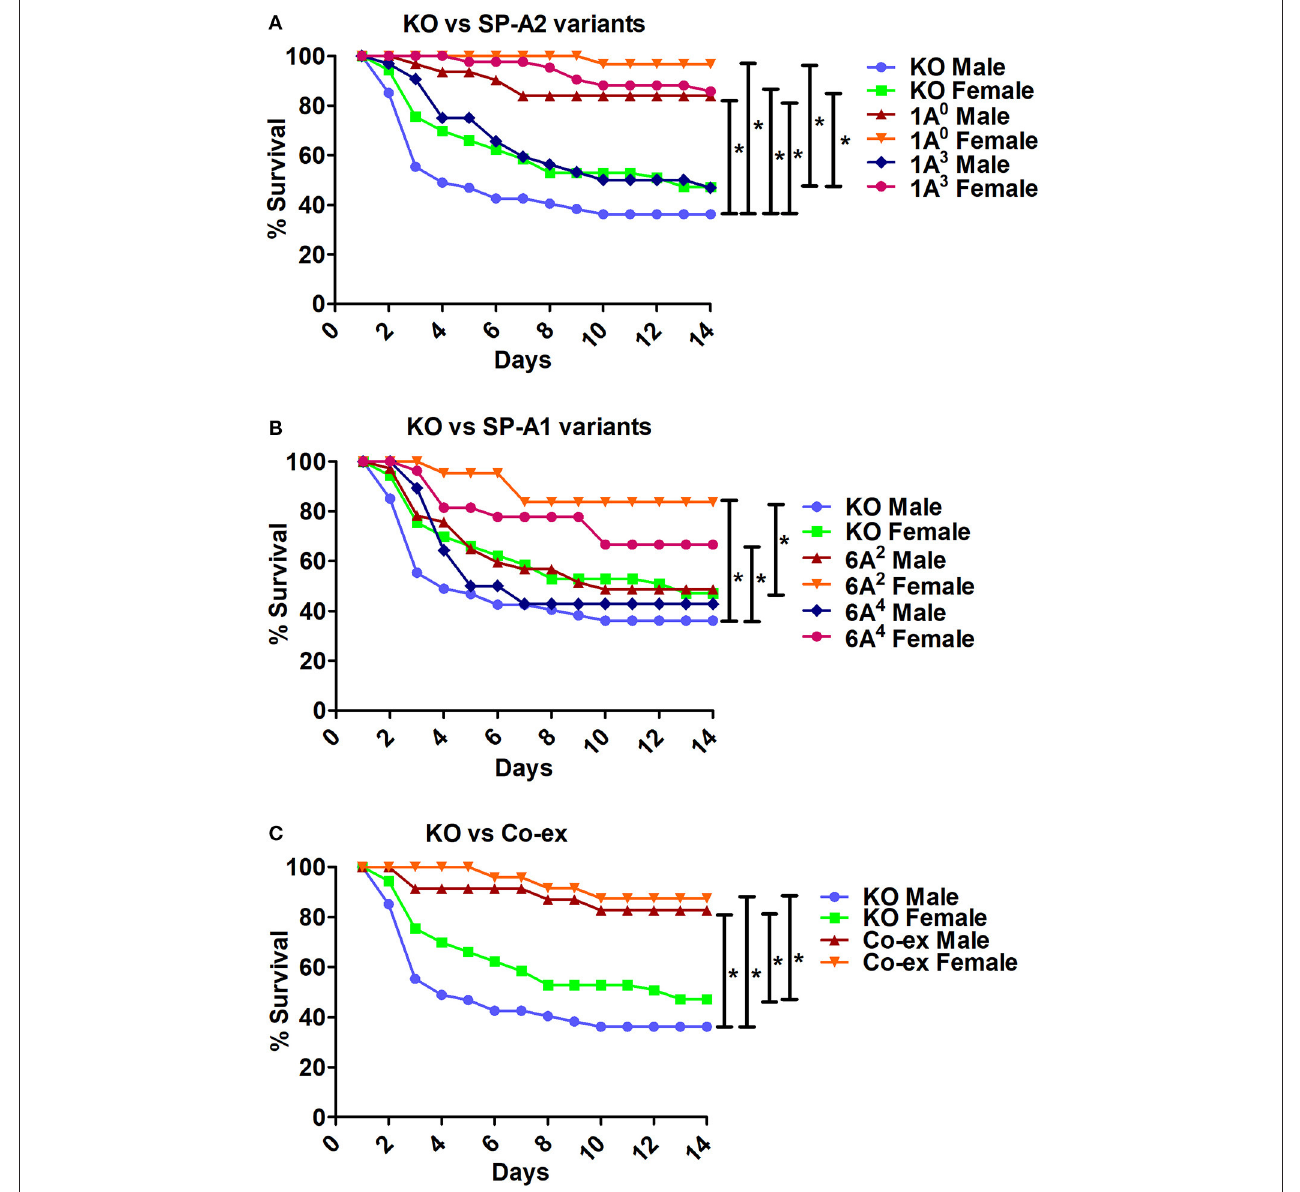
FIGURE 6 | Comparison of survival between KO and SP-A variants, and between KO and co-ex after K. pneumoniae infection . (A) Depicts differences in survival between males and females of KO vs. SP-A2 (1A 0 , 1A 3 ), (B) depicts differences between KO vs. SP-A1 (6A 2 , 6A 4 ), and (C) depicts differences between KO vs. co-ex. Mouse survival was monitored for 14 days after infection. Significant differences for survival are indicated * p < 0.05. The number of mice used for each group is shown in Figure 2